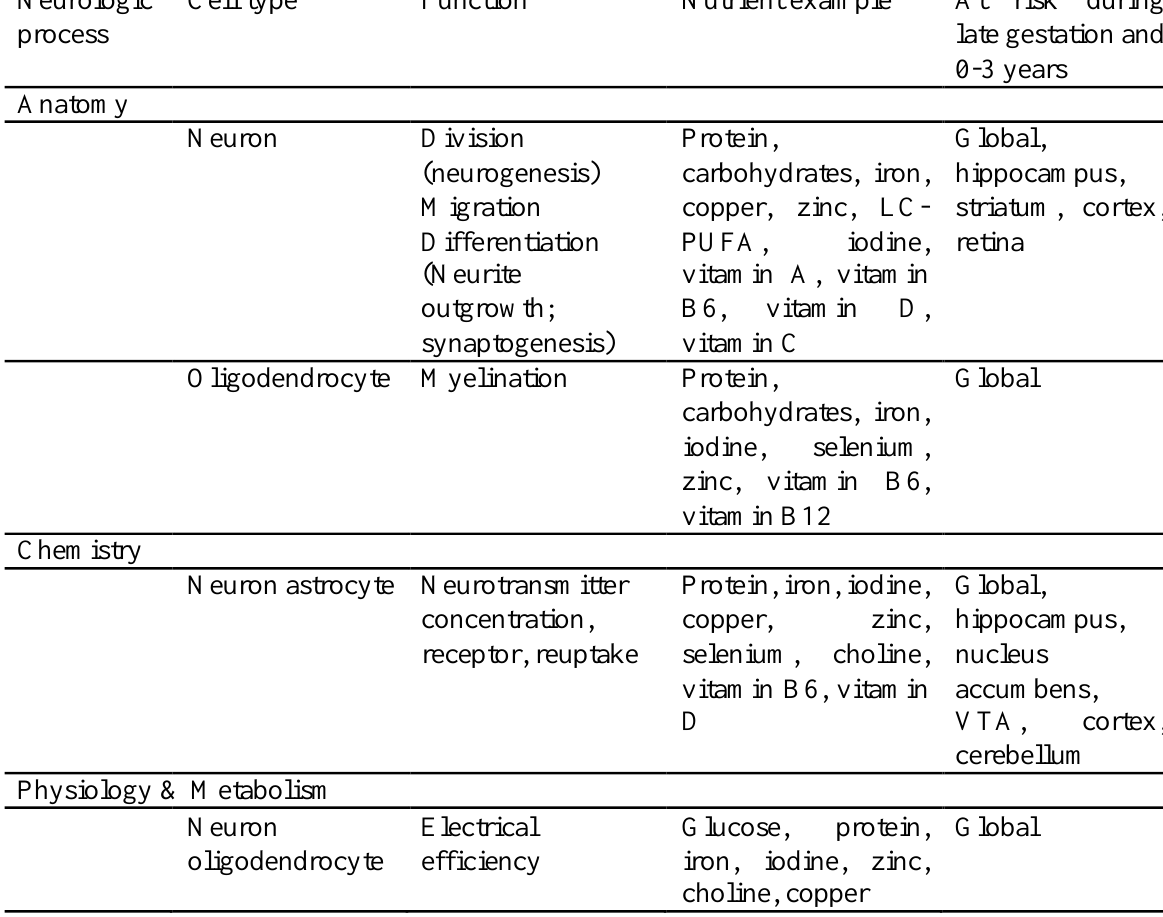
Table 1. Critical processes during neurodevelopment affected by specific nutrients